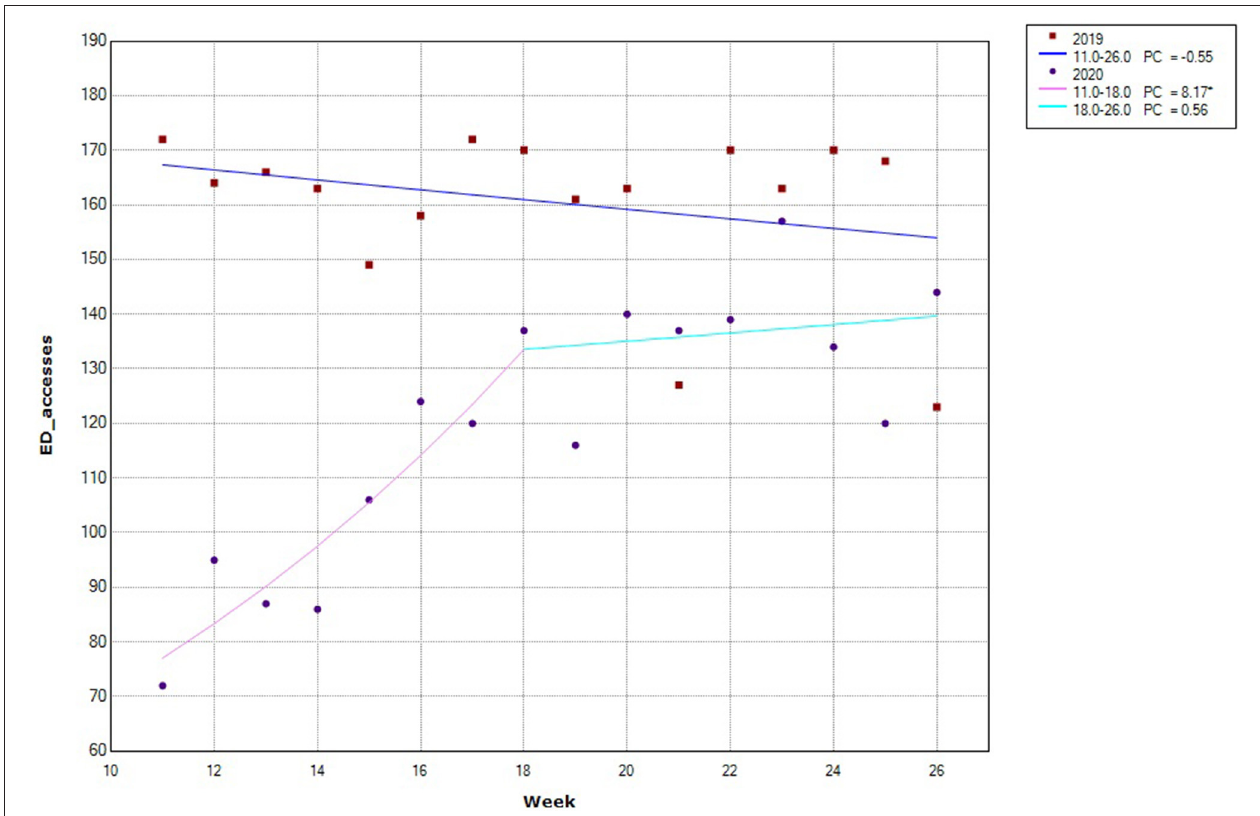
FIGURE 1 | Trend of HED consultations during the study period in 2019 and 2020. PC = weekly percentage change. *significant change. In 2019, no significant change in slope was observed, while in 2020 one change in slope was observed at week 18 (starting from April 29th), when consultations increased at a slower pace compared to the previous